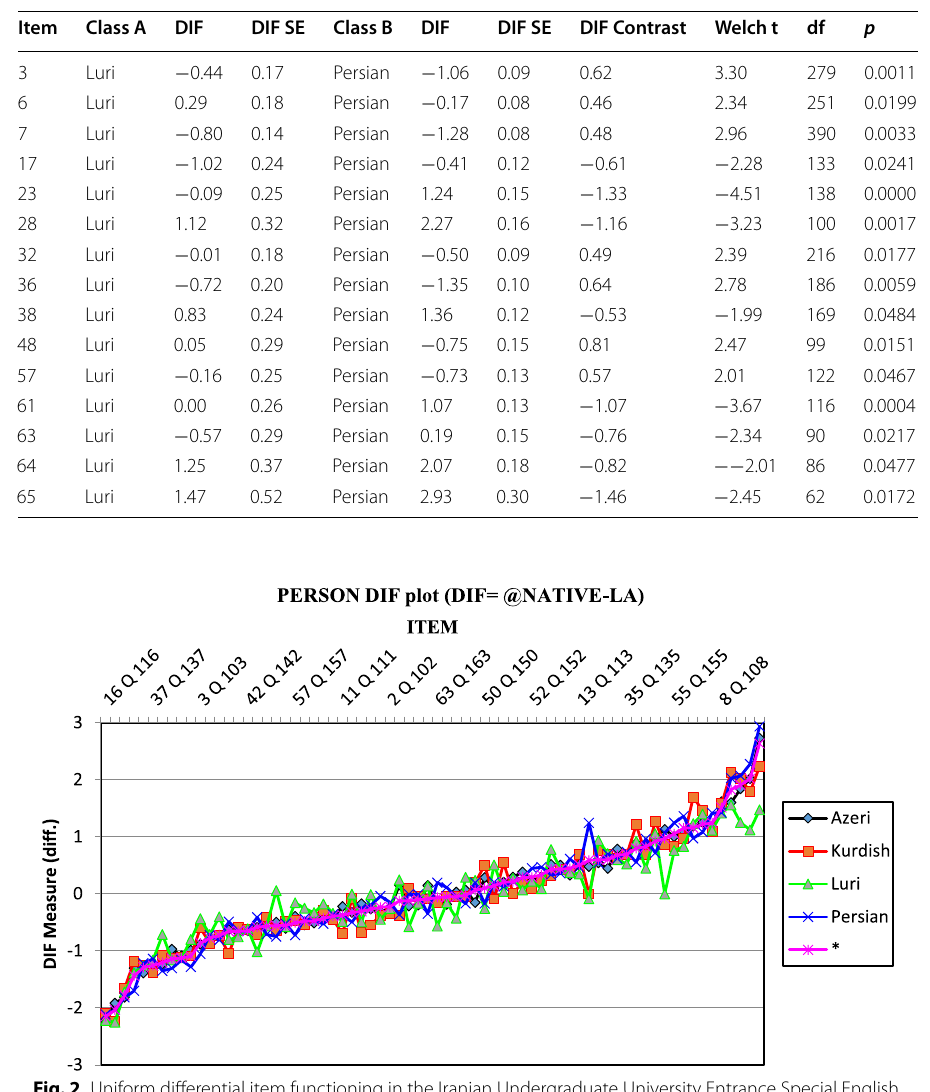
Table 5 Results of uniform DIF analysis of items (IUUESEE 2016)